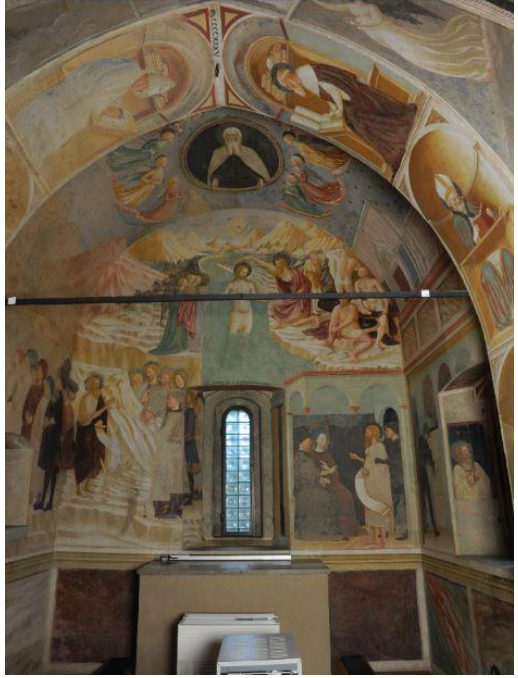
Figure 2: the interior of the Baptistery decorated with Masolino’s frescos